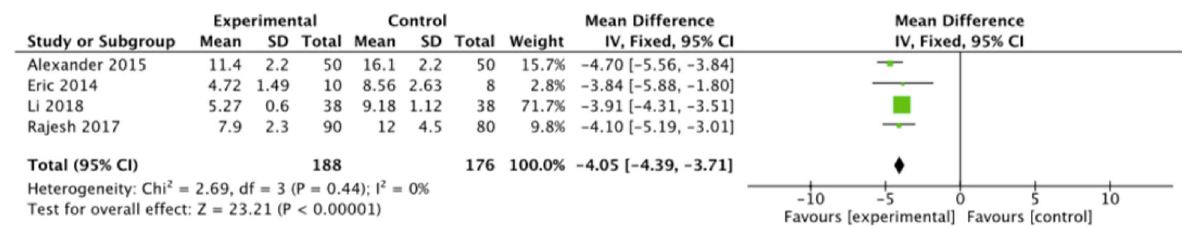
Fig. 6 Meta-analysis of time for capsular suture using barbed versus conventional sutures. There was a significant correlation (OR -4.05 [95% CI, − 4.39, − 3.71]) (Test for overall effect, p < 0.00001) between barbed suture (188 cases) and traditional suture (176 cases)